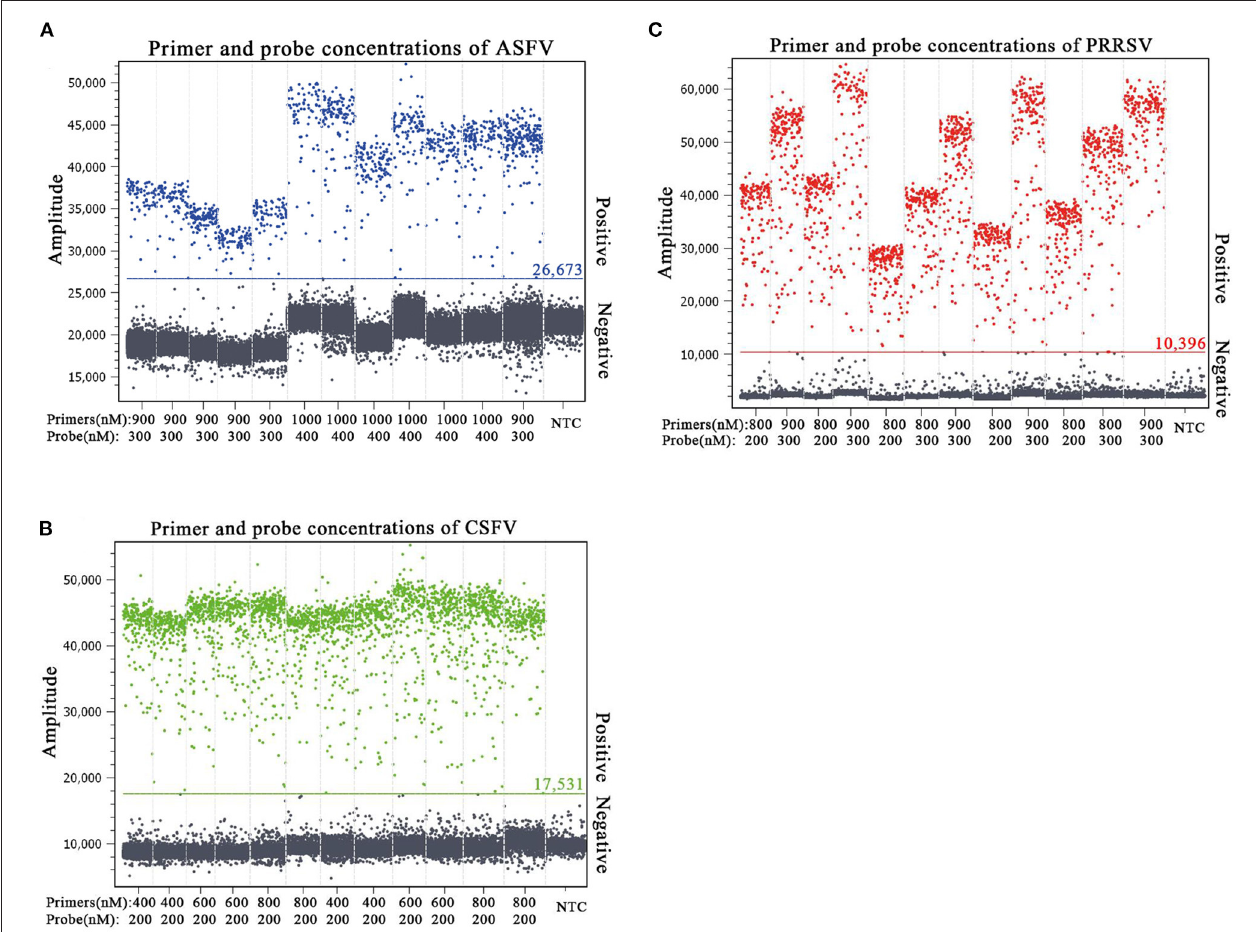
FIGURE 2 | Determination of the optimal primer and probe concentrations of the multiplex crystal dPCR for detection of ASFV (A) , CSFV (B) , and PRRSV (C) . The fluorescence amplitudes of different combinations of primer and probe concentrations for the multiplex crystal dPCR. NTC: no template